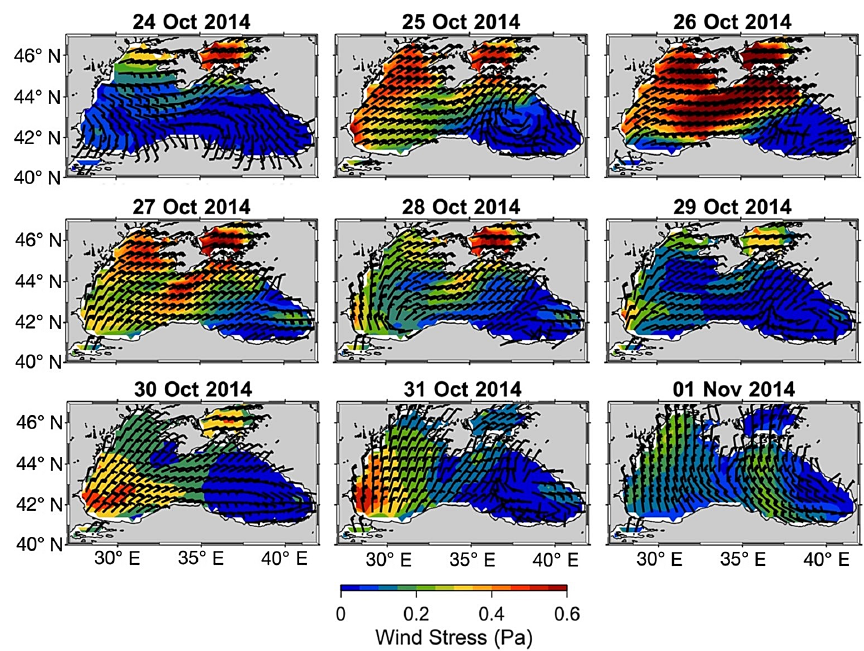
Figure 8. Sequence of wind stress (colour scale) and direction (wind barbs) distributions from 24 October to 1 November 2014 at 00:00UTC.